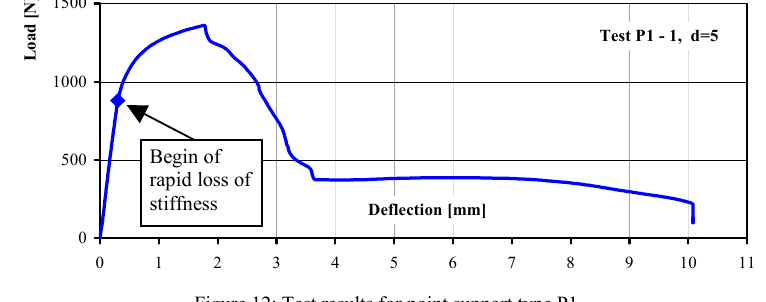
Figure 12: Test results for point support type P1.